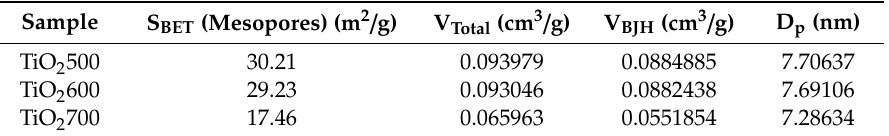
Figure 5. Nitrogen adsorption–desorption isotherms ( a ) and pore size distribution ( b ) of fibrous TiO 2 samples obtained at various annealing temperatures. Table 2. Porosimetry data for the fibrous TiO 2 samples.